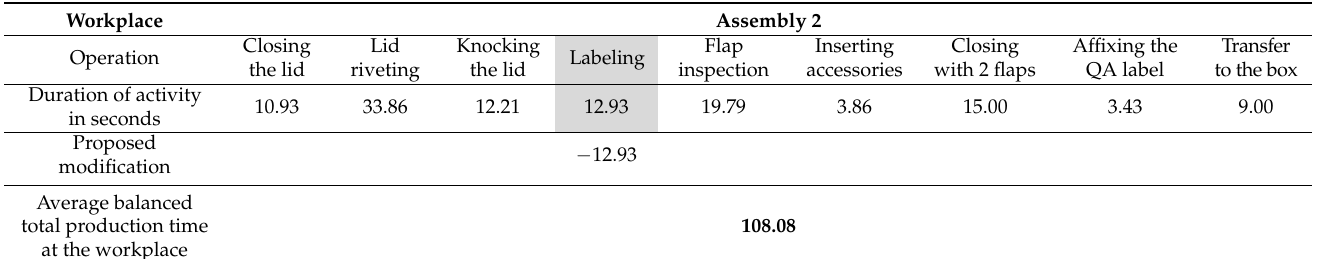
Table 8. Average balanced total production time at the workplace Assembly